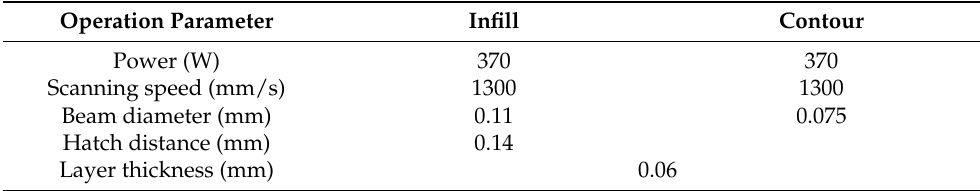
Table 2. Process parameters specified for drawing infill and contour by laser.